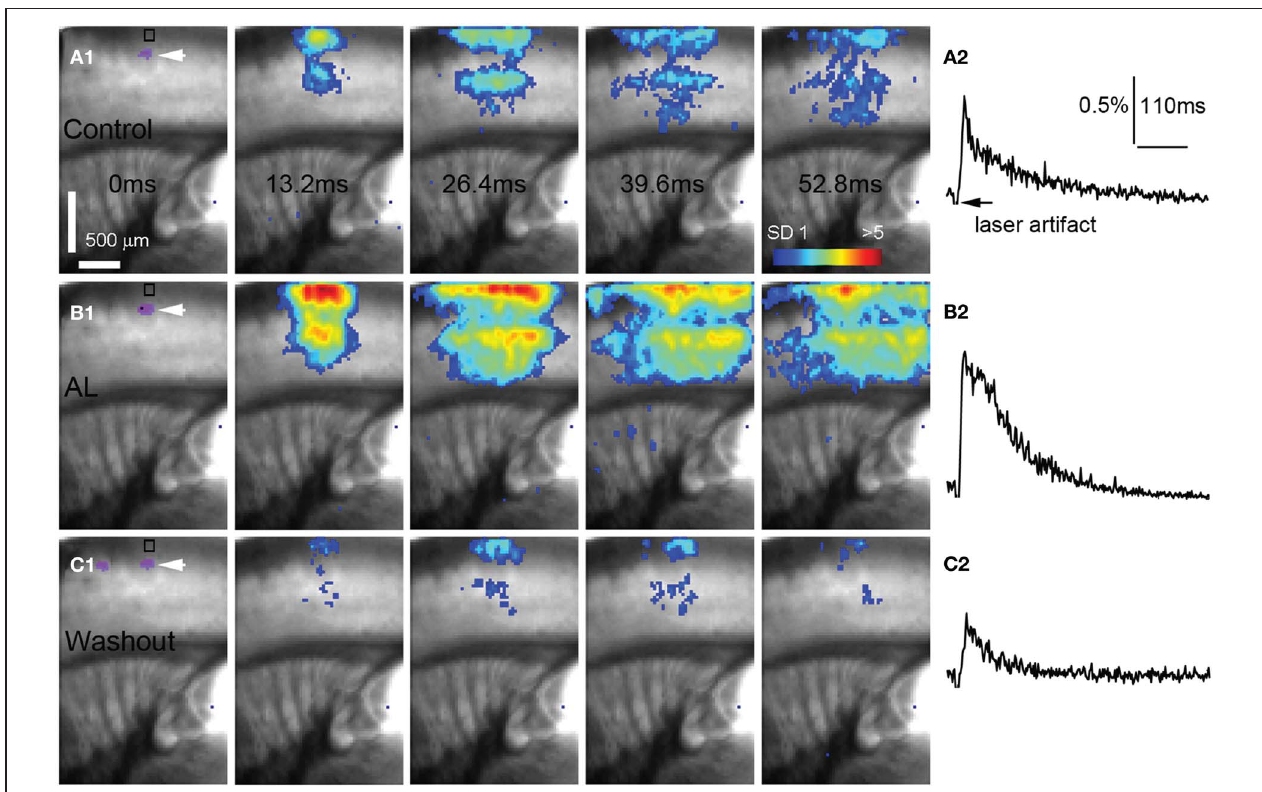
respectively. The site of photostimulation is in cortical layer 4. (A2–C2) The time course of VSD signal (in the percent change of pixel intensity [ (cid:3) I / I %]) from the ROI indicated by the small rectangle in the first image frame in (A1–C1) ,